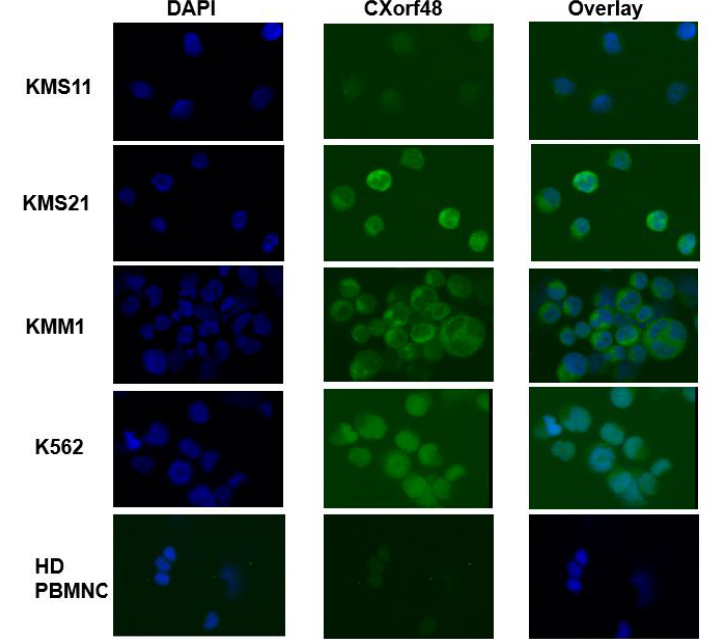
Figure 2. CXorf48 protein expression in MM cell lines. Expression of protein was detected using immunocytochemistry in KMS11, KMS21, KMM1, K562 (positive control), and peripheral blood mononuclear cells were detected in a healthy donor (HD PBMNC; negative control). These cells were stained with 4′,6 -diamidino-2-phenylindole (DAPI) and mouse anti-CXorf48 antibody followed by staining with Alexa488-labeled goat anti-mouse IgG. Vaccines 2020 , 8 , x 7 of 13